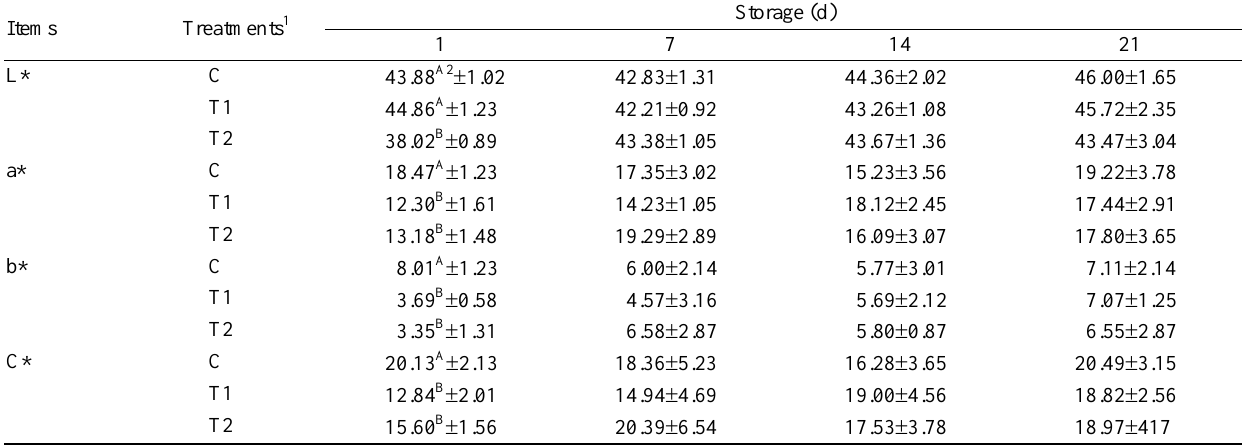
1 C: ziplock bag packaging, T1: vacuum packaging, and T2: MAP (CO 2 A-B Means  SD with different superscripts in the same column differ significantly at